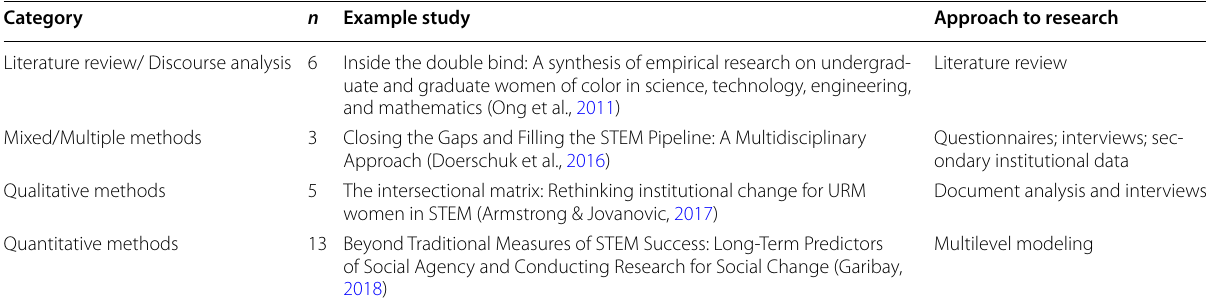
Table 3 Research design